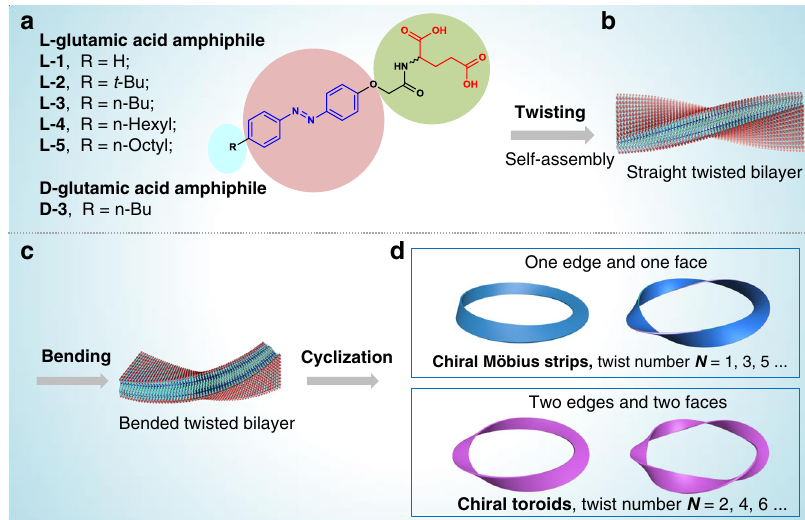
Fig. 1 Schematic representation of forming supramolecular Möbius strips and chiral nanotoroids through amphiphile self-assembly. a Molecular structures of L- and D-glutamic acid-derived amphiphiles L-1 – L-5 and D-3, respectively. b Amphiphiles fi rst self-assemble into straight twisted bilayers, c which then bends into bent twisted bilayers. d Cyclization of bent fi ber leads to the formation of chiral toroidal fi bers. When the twist numbers on toroidal fi bers are odd ones, chiral Möbius strips can be identi fi ed by electron microscopic